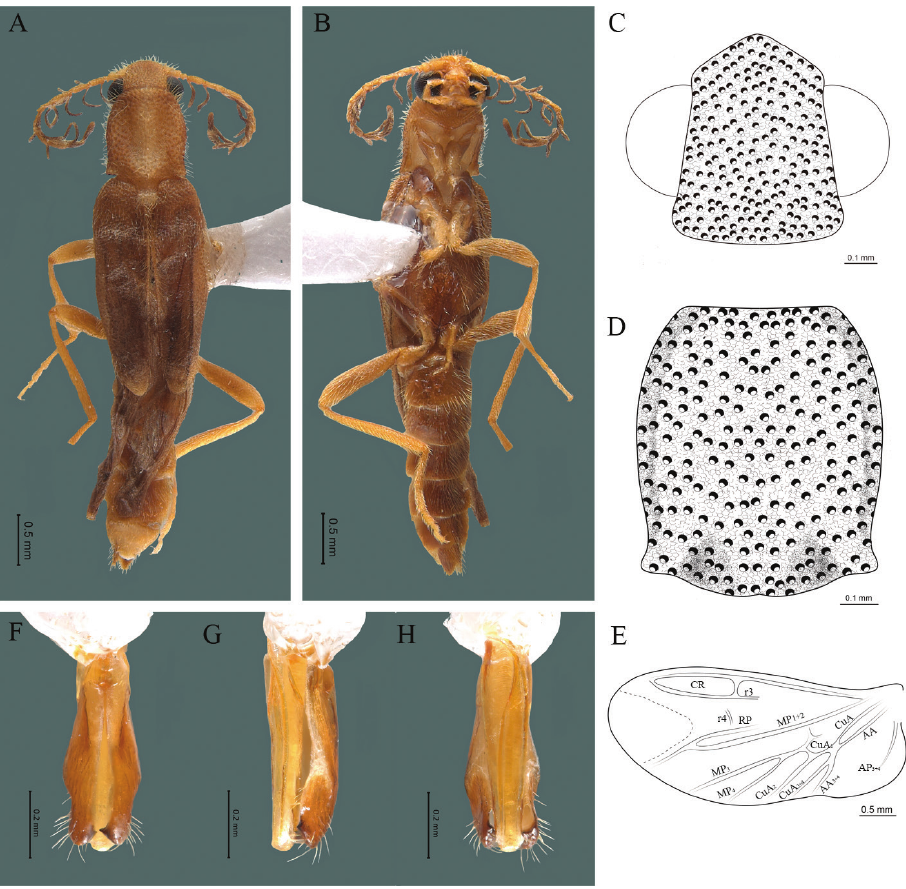
Figure 29. Cenophengus tupae Vega-Badillo et al. 2021, male. Habitus: A dorsal B ventral C head dorsal D pronotum dorsal E hind wing. Wing venation: CR = Radial Cell; r3 = radial 3 vein; r4 = radial 4 vein; RP = Posterior Radial vein; MP1+2 = Posterior Median, vein; CuA = Cubital vein; AA and AP = Anterior and Posterior Anal veins. Aedeagus: F dorsal view G lateral view H ventral